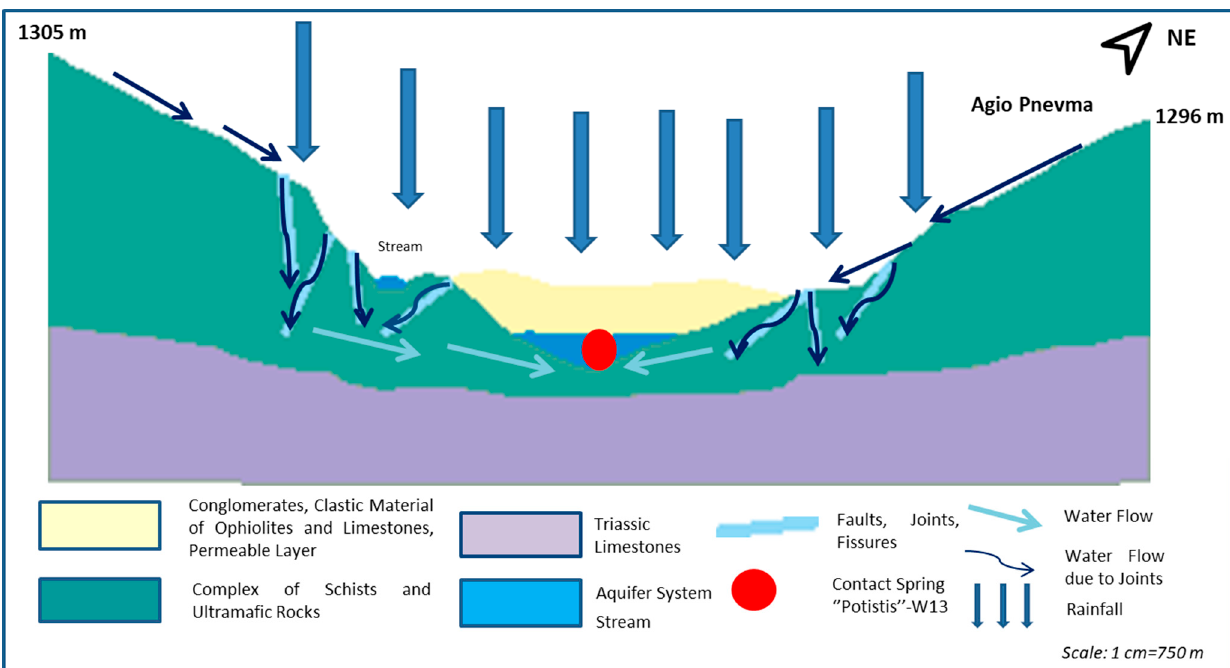
Figure 3. Simplified hydrogeological section of the natural spring ’’Potistis‘’ ‒ W13 in western Vermio Mt.